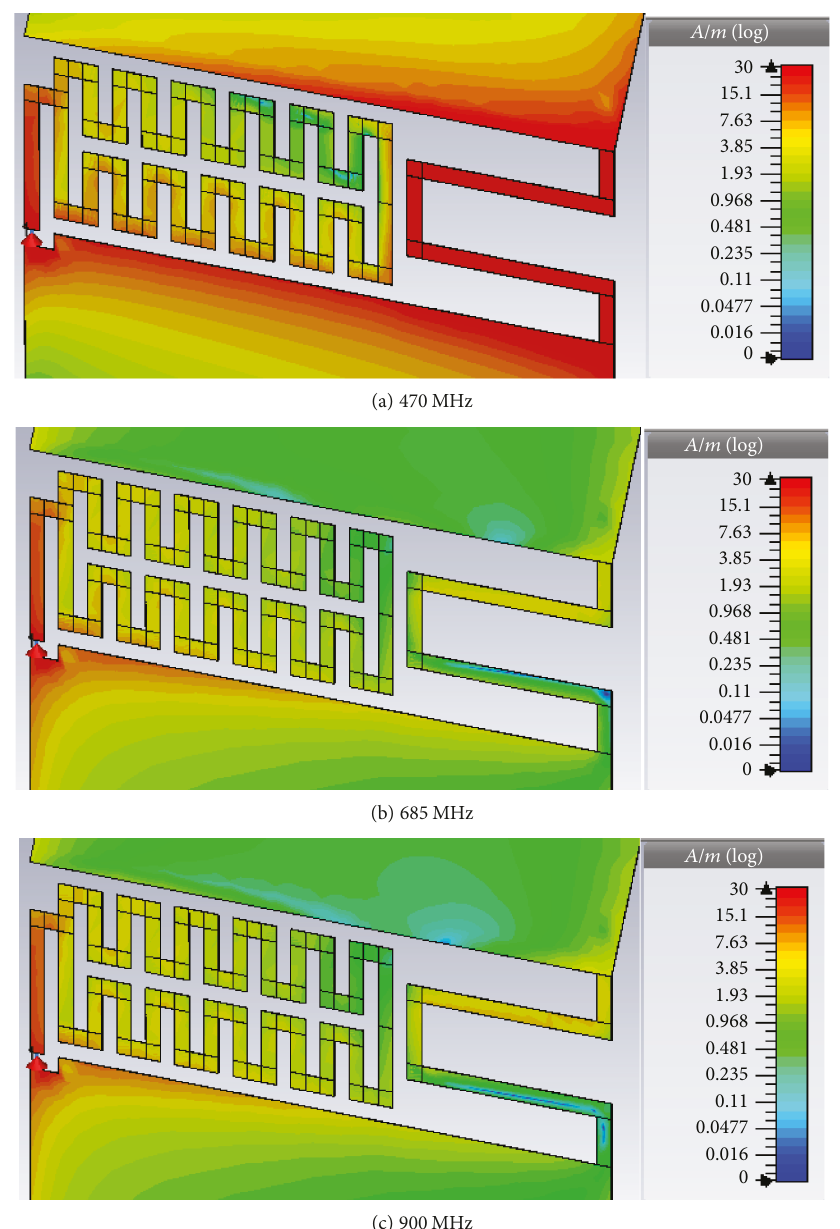
Figure 6: Simulated surface current of the MD-loaded MLA at (a) 470MHz, (b) 685 MHz, and (c) 900